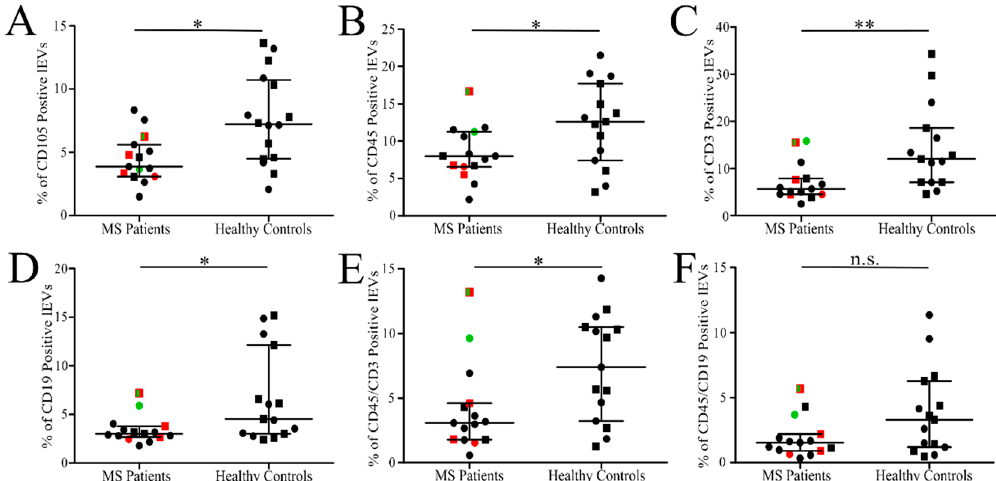
Figure 5. Relative number of labelled isolated lEVs in MS patients and HC. Percentage of endothelial CD105+ ( A ), leukocyte CD45+ ( B ), T-lymphocyte CD3+ ( C ) and CD45+CD3+ ( E ), B-lymphocyte CD19+ ( D ) and CD45+CD19+ ( F ) lEVs out of all events collected in lEVs gate. The line represents median value with interquartile range. Women (circles), men (squares), patients without treatment (green), patients receiving intravenous corticoids up to 14 days before blood collection (red). * p < 0.05, ** p < 0.005, n.s.—not significant; MS patients ( n = 15) and HC ( n = 15 or n = 16). Table 1. Analysis of fresh lEVs isolated from blood plasma of MS patients and healthy controls. Results of flow cytometry analysis of lEVs isolated from blood plasma of MS patients and healthy controls by differential centrifugation. “All events” and “events in lEVs gate” represent event counts recorded “within and outside” or “only within” the lEVs gate, respectively. Left side of the table represent counts of labelled lEVs detected in µ L of plasma. Right side of table represents relative numbers of lEVs related to all events detected in lEVs gate (%). Mean values with 95% confidence interval are presented. MS patients ( n = 15); healthy controls ( n = 16 or * n = 15). Analysis of Fresh lEVs Isolated from Blood Plasma of MS Patients and Healthy Controls Count of Positive lEVs/ µ L of Plasma % of Positive